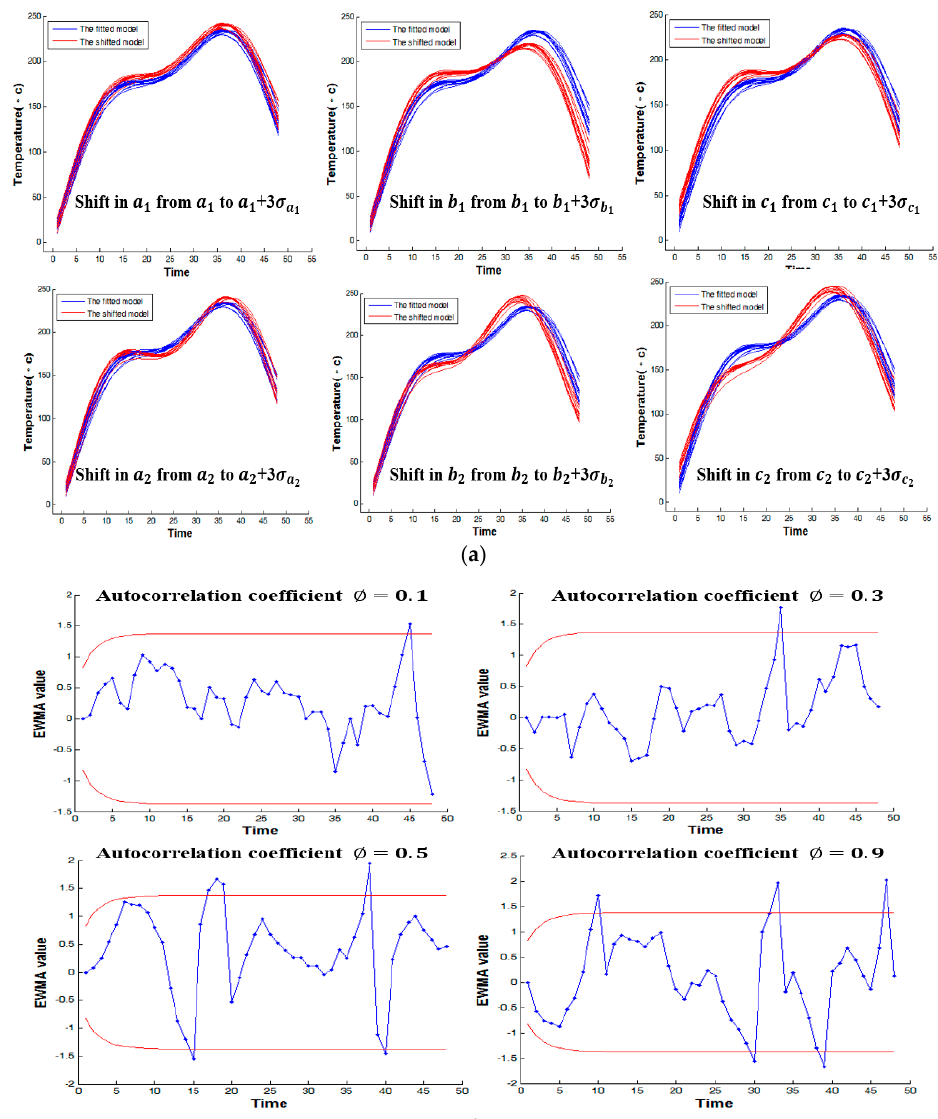
Figure 10. Phase II analysis. ( a ) Detecting the curve changes using different shifts of process parameters; and, ( b ) Detecting the autocorrelation effect of residuals using exponentially weighted moving average (EWMA) control chart.